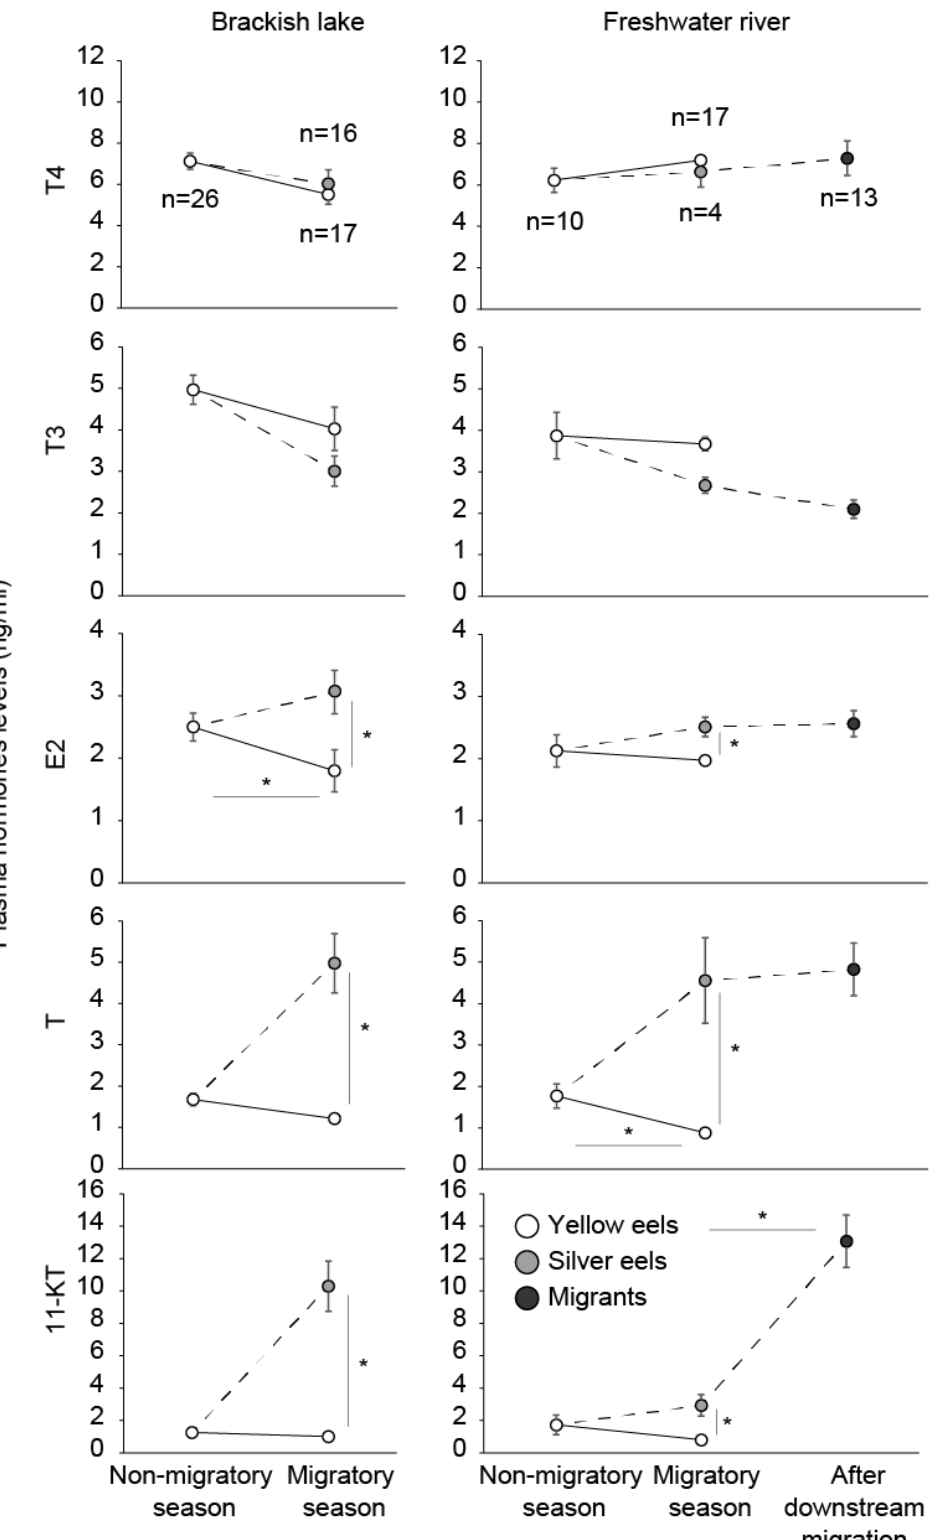
Figure 4. Seasonal changes of the steroid hormones (E2, T and 11-KT) and the thyroid hormones (T4 and T3) for each type of female Japanese eels ( A. japonica ) from both the brackish lake and its freshwater inlets. This figure is based on data from Sudo et al. 2011. Asterisks show significant differences between each group ( p < 0.05; Steel-Dwass).